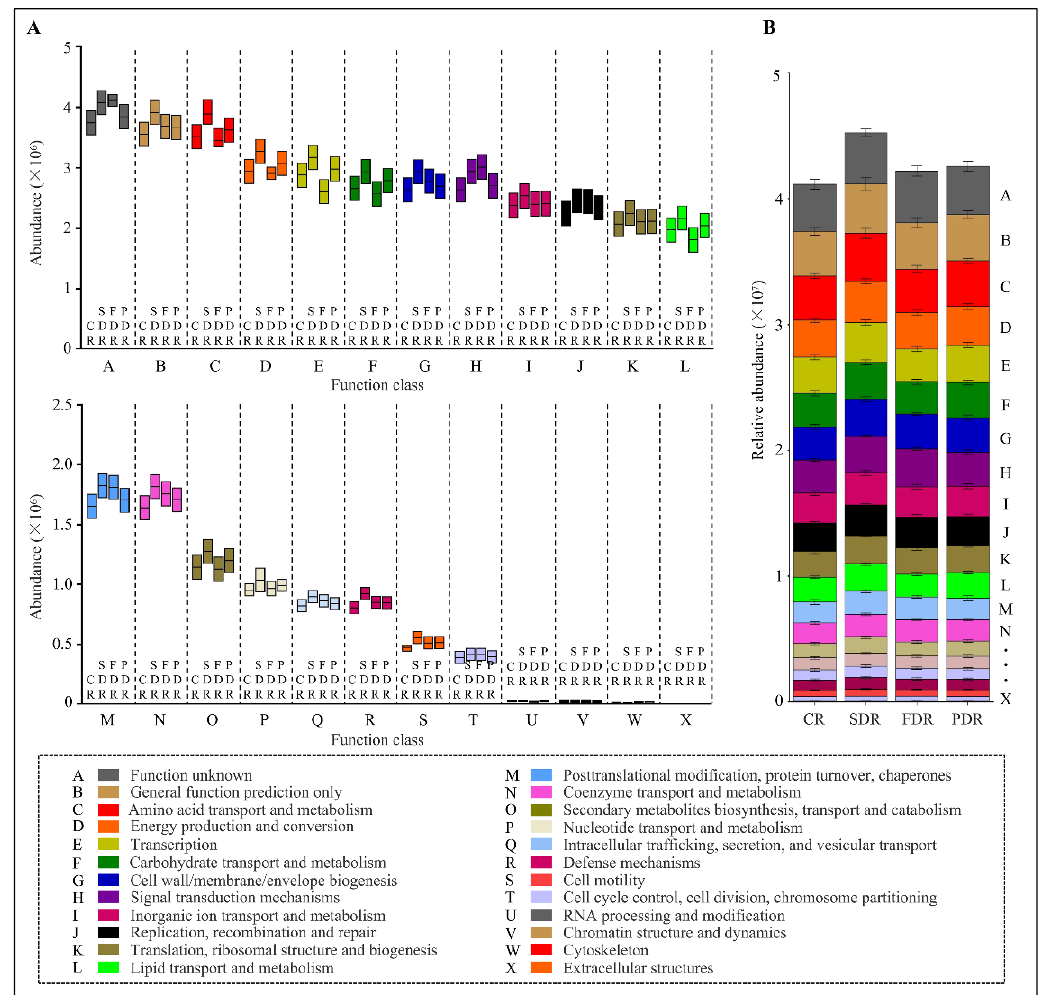
Figure 7. The microbial functional features in three drought-treated soil groups via Cluster of Orthologous Groups (COG) analysis. ( A ) Box-plot showing the relative abundance and diversity of various functional groups in drought-treated and untreated soil groups. ( B ) Bar chart showing the relative abundance and diversity of functional groups in drought-treated and untreated soil groups. The relative abundance is calculated by averaging the abundances of duplicate samples. Di ff erent COG groups were displayed in di ff erent colors in the